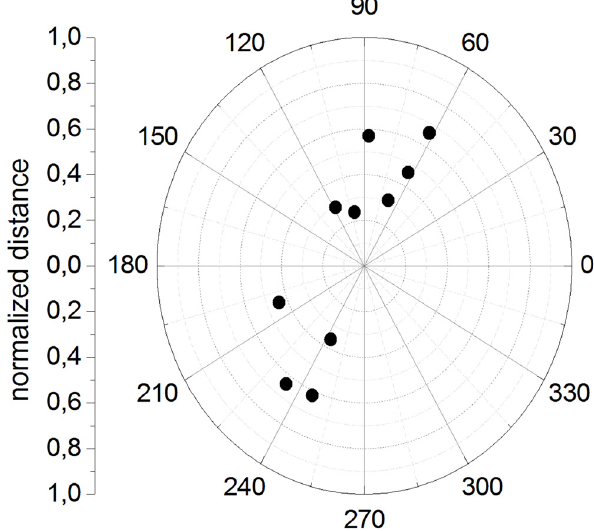
Fig. 9. Position of pingos within single basins. Normalized dis- tances and angles (in ◦ ) were calculated between basin centroids and pingos. 0 ◦ =East, 90 ◦ =North, 180 ◦ =West, 270 ◦ =South.